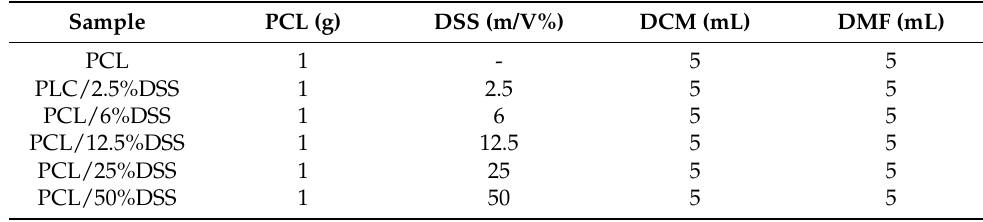
Table 1. Solutions prepared for